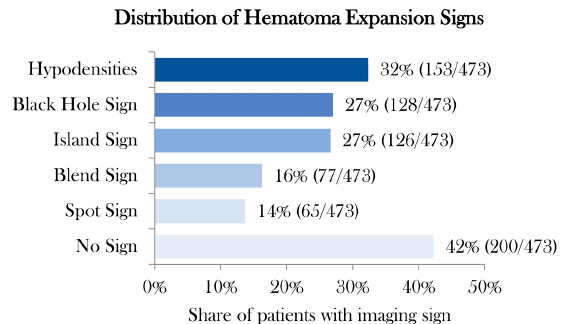
Figure 1. Distribution of hematoma expansion sign. Legend: Distribution in percentage and absolute numbers of four noncontrast computed tomography imaging signs and spot sign on computed tomography angiography. Table 2. Distribution of modified Rankin Scale at discharge according to the presence of imaging markers for early hematoma expansion in patients with spontaneous intracerebral hemorrhage. Imaging Signs for mRS mRS > 3 Presence ICH Expansion [median] [%] Imaging Signs for All NCCT Signs and Spot Sign on CTA ICH